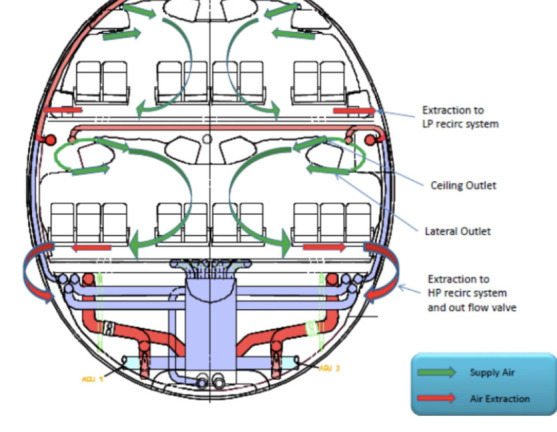
Ventilation system of airbus.7